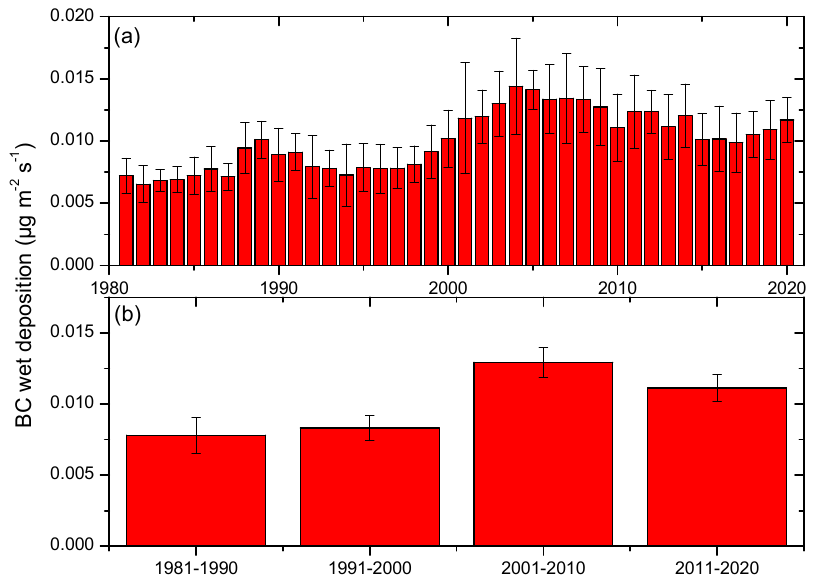
Figure 3. Annual variations of area-averaged black carbon wet deposition flux over the Sichuan basin from 1981 to 2020 ( a ) and in four periods ( b ) during 1981–1990, 1991–2000, 2001–2010 and 2011–2020.